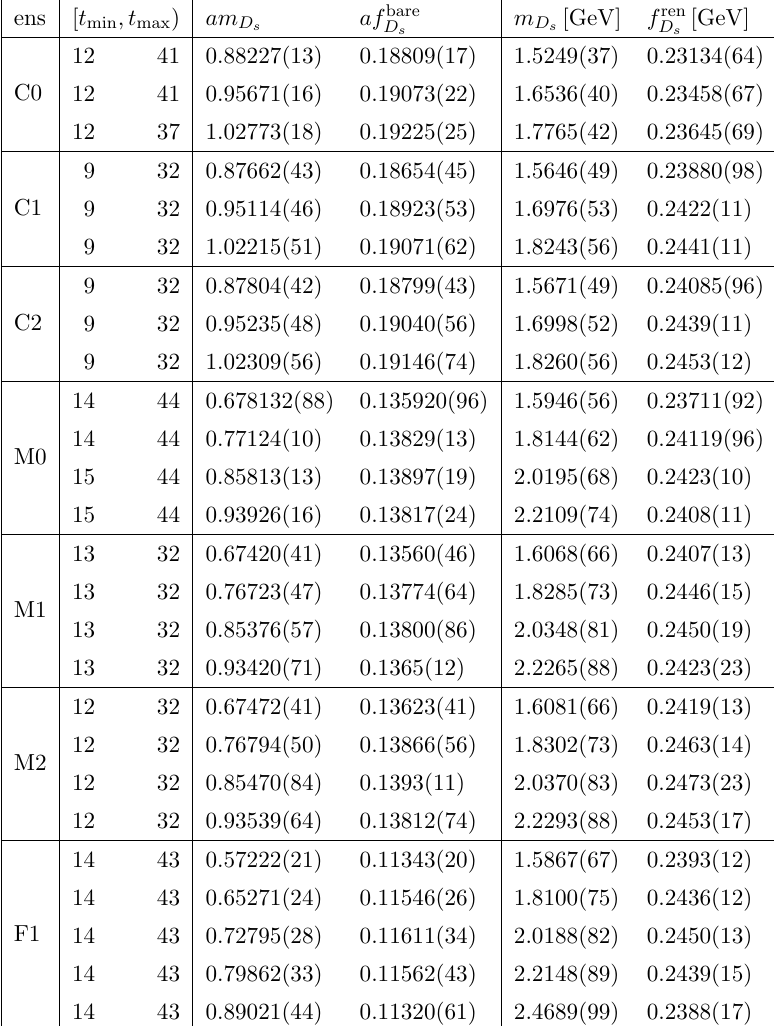
Table 12 . Fit results for the masses and decay constants of the D s meson on all ensembles. The second set of columns is renormalised where the renormalisation constants are obtained from the light-light conserved current as described in the text. The results stated here are those for the strange quark mass closest to the physical one.